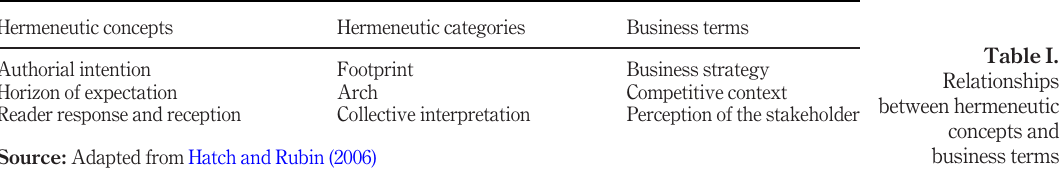
Table I. Relationships between hermeneutic concepts